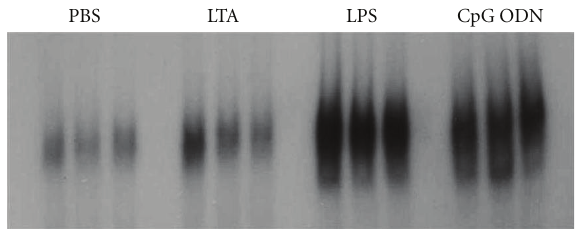
Figure 1: NF κ B activation. Representative EMSA for pulmonary nuclear NF κ B activity in LTA-, LPS- and CpG-ODN-stimulated mice ( n = 3/group) after 2h. Each lane represents an individual animal. LPS induced the strongest signal followed by CpG-ODN and LTA.